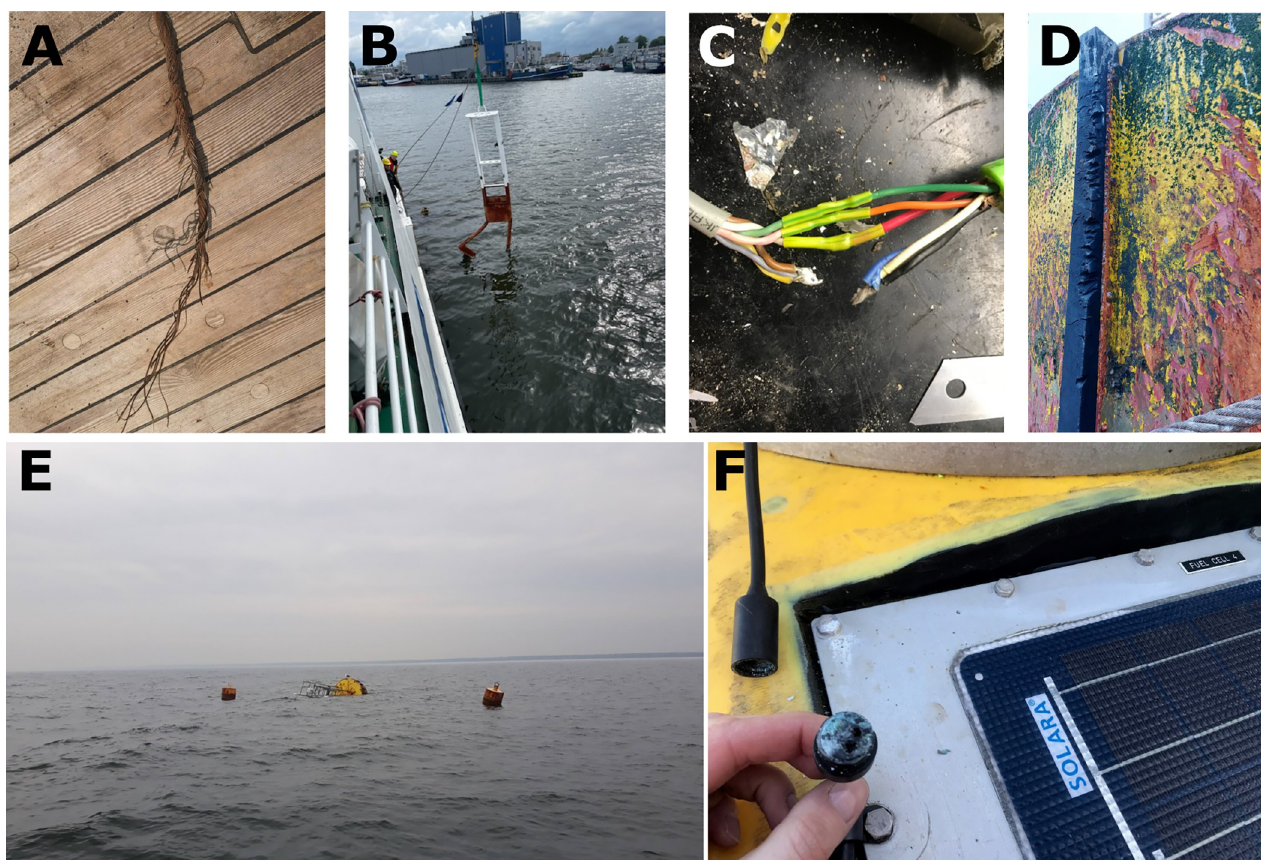
Fig 8. Examples of mechanical damage. A) Steel rope of the ship’s crane broken when lifting a device from the seabed, B) Hitting the MBES frame on the underwater installation, which resulted in a deformation of the frame and loss of the device, C) Broken cable, D) Damage to the measuring buoy plating due to a collision with another floating object, E) Tipping over of the measurement buoy after breaking the anchor due to severe weather conditions, collision / trampling by other floating object / lack of appropriate services, F) Damaged